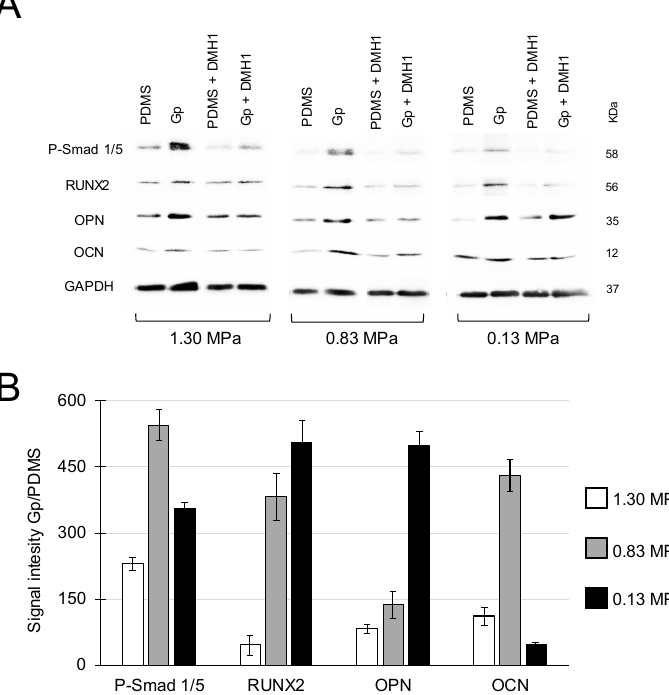
Figure 5. ( A ) MSCs grown on Gp exhibited greater increases of Smad p1/5 and of the classical markers for osteogenic differentiation, RUNX2, OPN and OCN. The expressions of p-SMAD increased by >180% on Gp compared to PDMS alone. The treatment 50 µM of DMHI decreased the expression of all protein studies. ( B ) Relative quantification of all groups in the absence of inhibitors. Signal intensity is in arbitrary units.